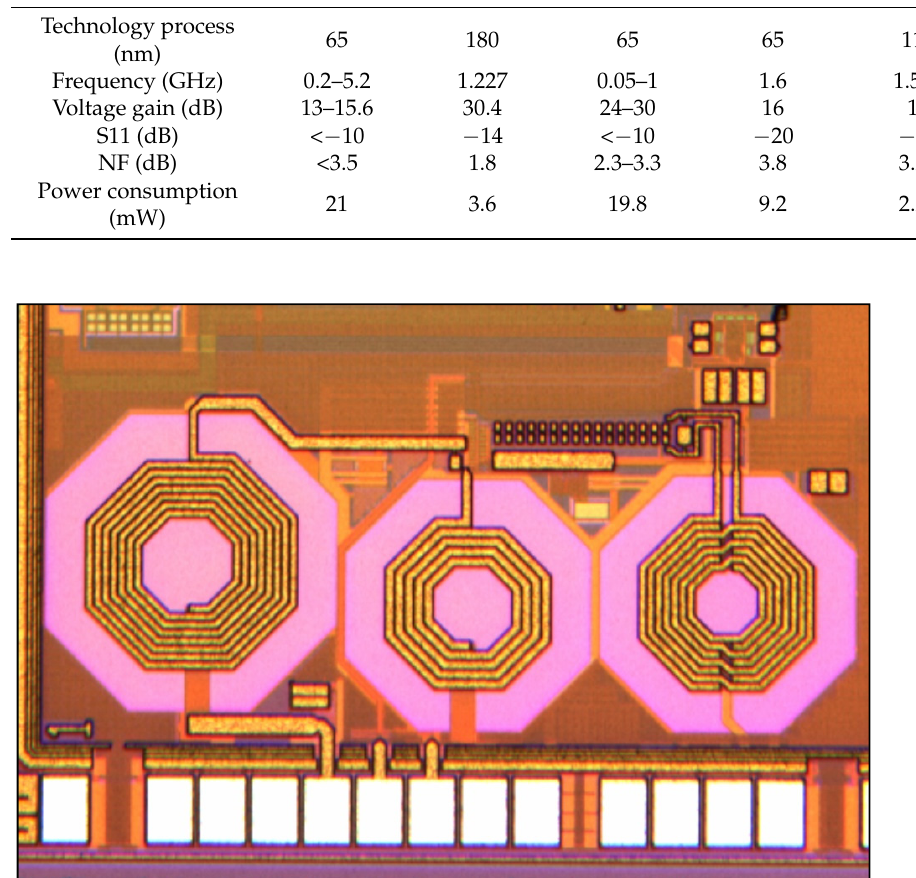
Figure 25. Balun and mixer microphotography.